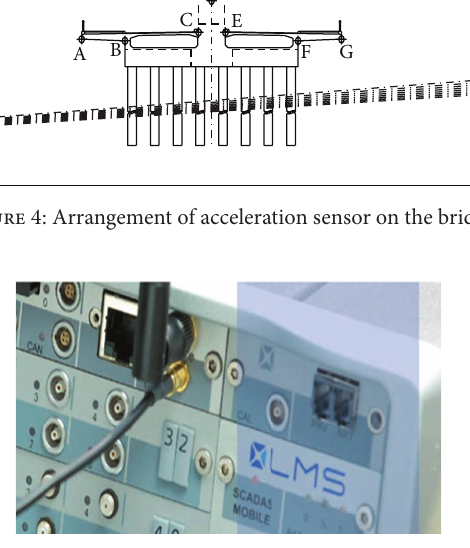
Figure 5: Data acquisition system of LMS.